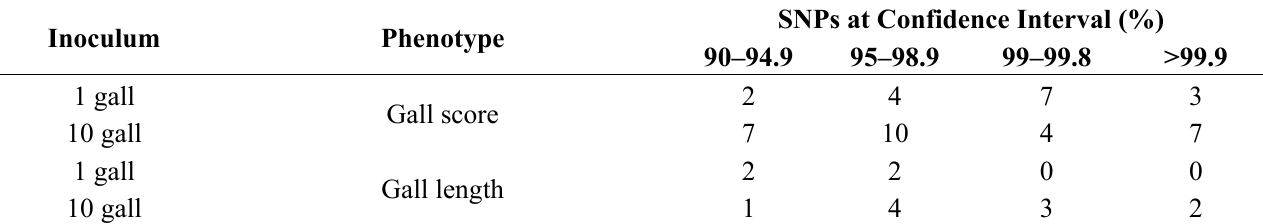
Table 1. Significant SNPs after tandem BayesC  and BAMD analysis for resistance to fusiform rust.